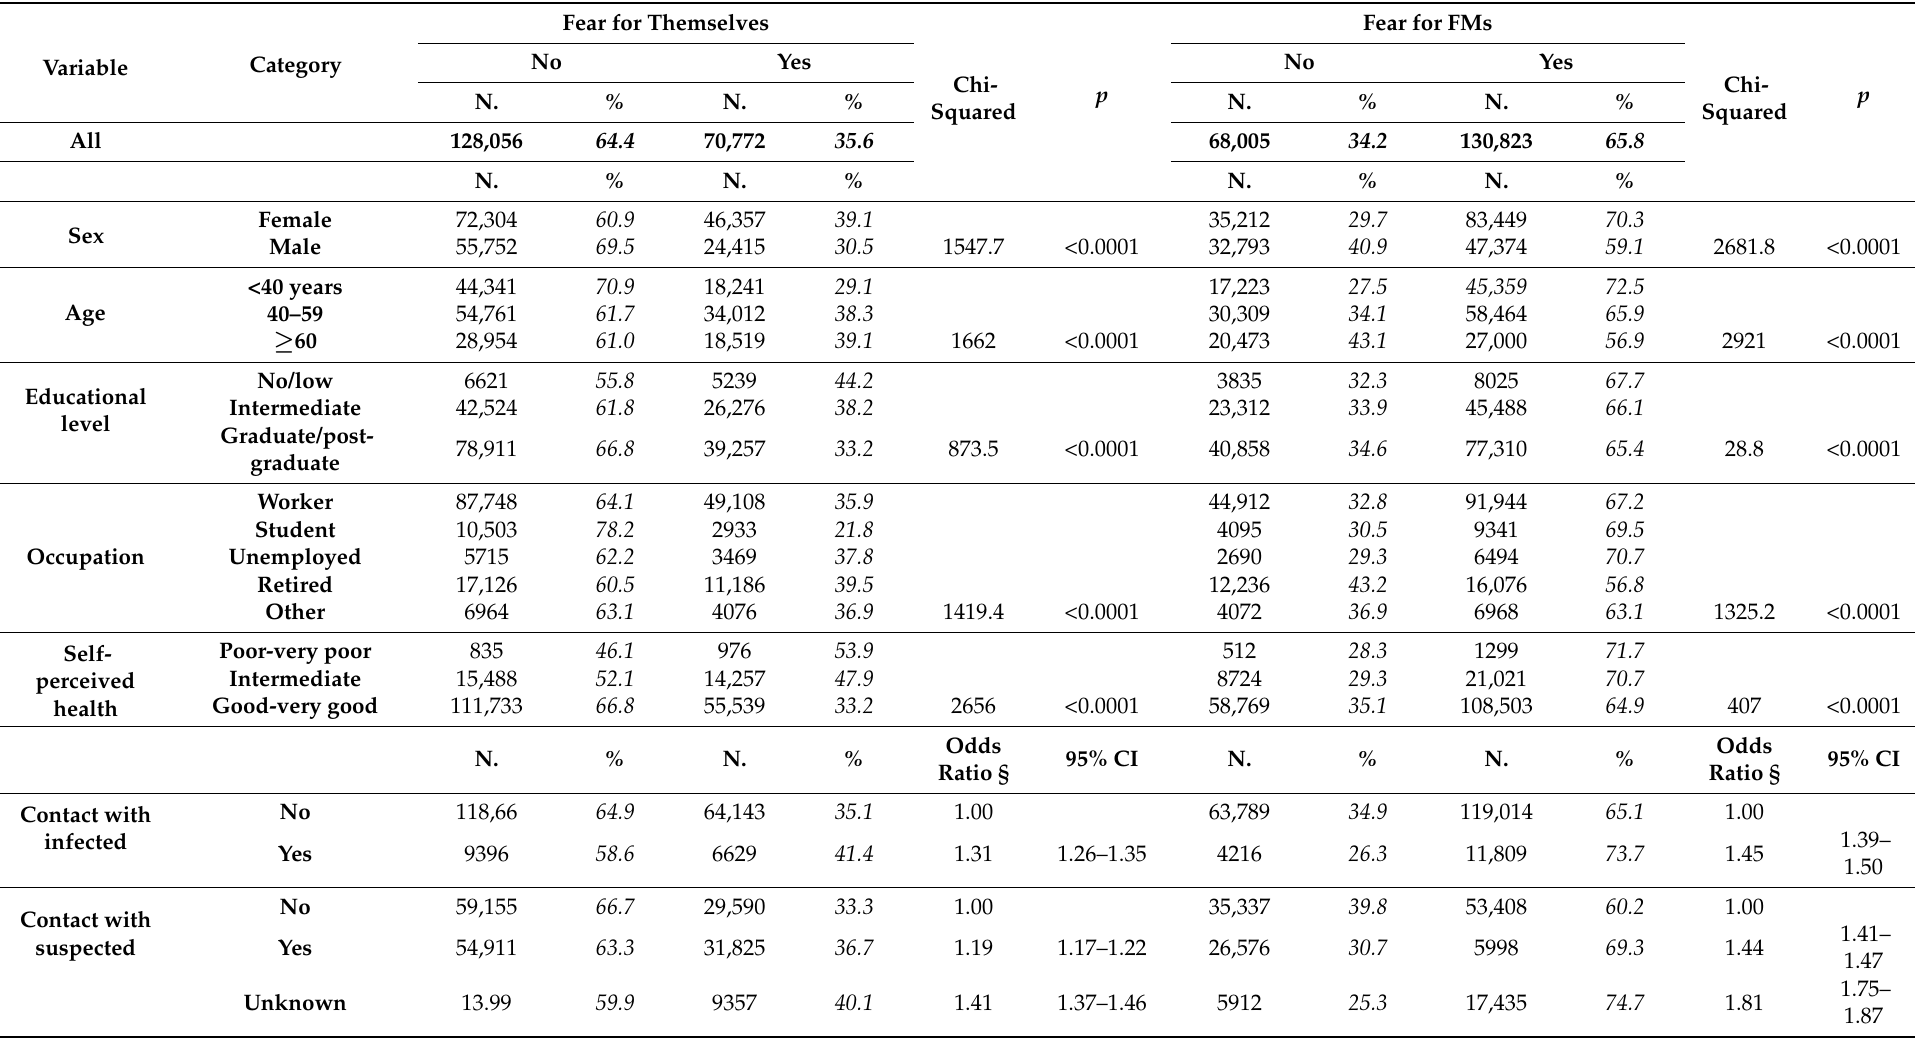
Table 1. Fear for themselves and for family members (FMs) according to selected variables obtained by the self-administered EPICOVID19 survey questionnaire.